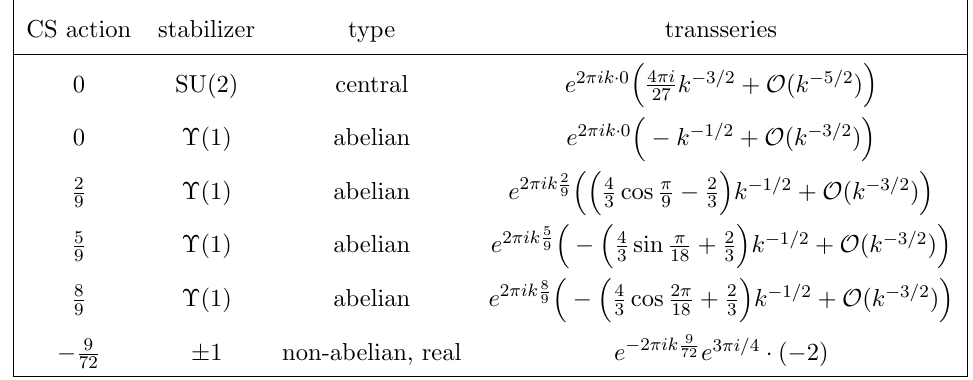
2; 1 ; 1 ; 2 ) up to an overall 2 3 3 (cid:0)